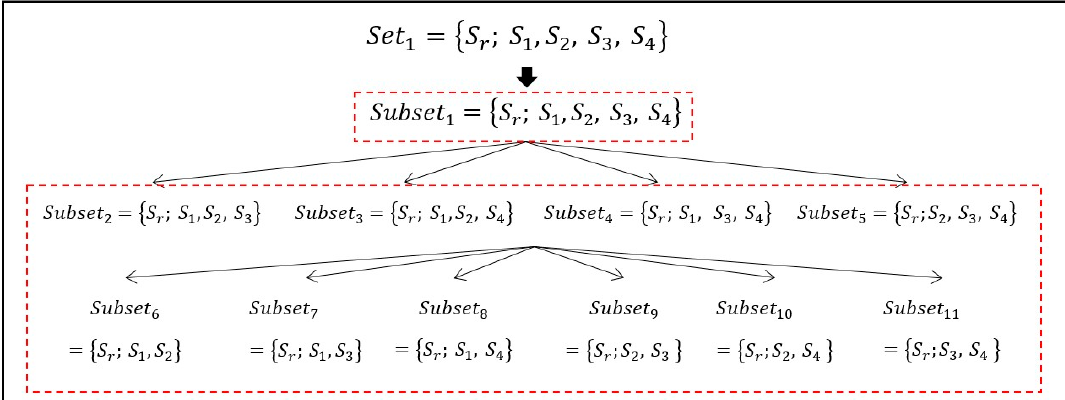
Figure 3. Example of cascade of 11 subsets in the case of Set 1 .